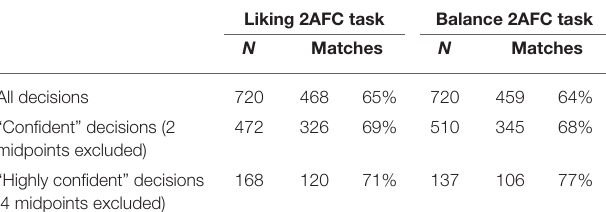
TABLE 3 | Absolute case numbers and percentages of matches that support the predictions of Instagram Likes and balance scores,